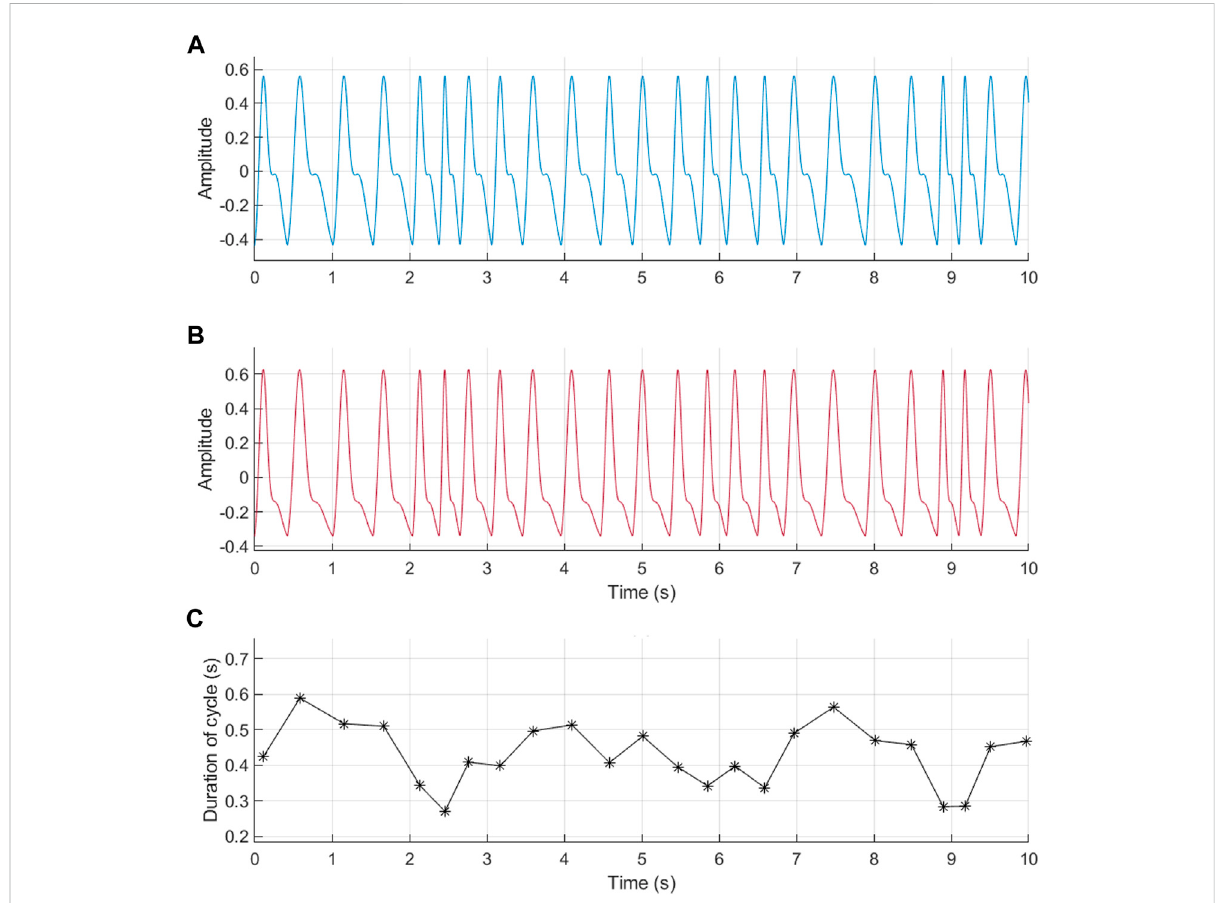
FIGURE 2 Example of photoplethysmographic (PPG) signals simulated using the proposed model and randomly generated pulse rate variability (PRV) information. (A) PPG signal with excellent quality ( r = 2). (B) PPG signal with acceptable quality ( r = 4). (C) PRV information used for the generation of these